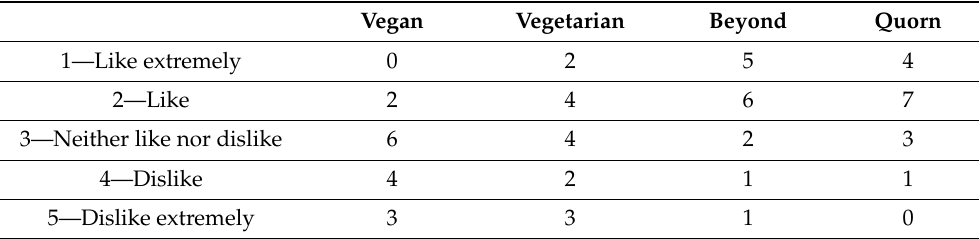
Table 2. Preference profiles regarding taste across the participants ( n =